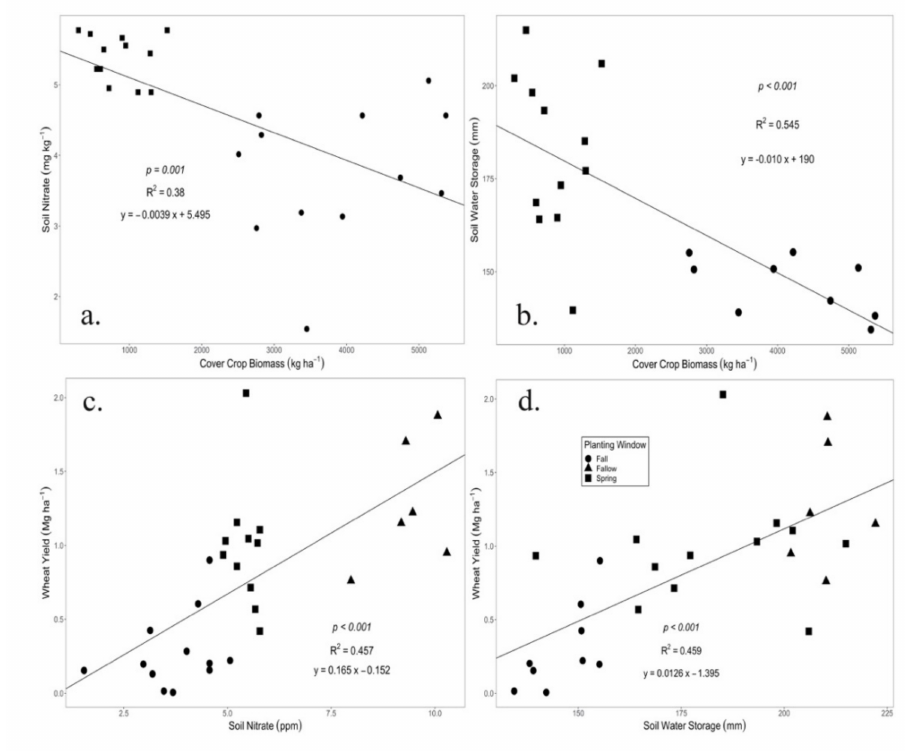
Figure 4. Correlations between: ( a ) cover crop biomass (2017) and subsequent soil nitrate levels, ( b ) cover crop biomass and soil water storage in the top 90 cm of the soil profile at 2018 wheat planting in a field experiment (T2) located at the Southwestern Colorado Research Center in Yellow Jacket, CO. Correlations also shown between soil nitrate levels ( c ) and soil water storage ( d ) at wheat planting and 2018 wheat yields. Shapes indicate different cover crop planting windows. Multiple R 2 , p -values, and equations for associated linear regressions are displayed on